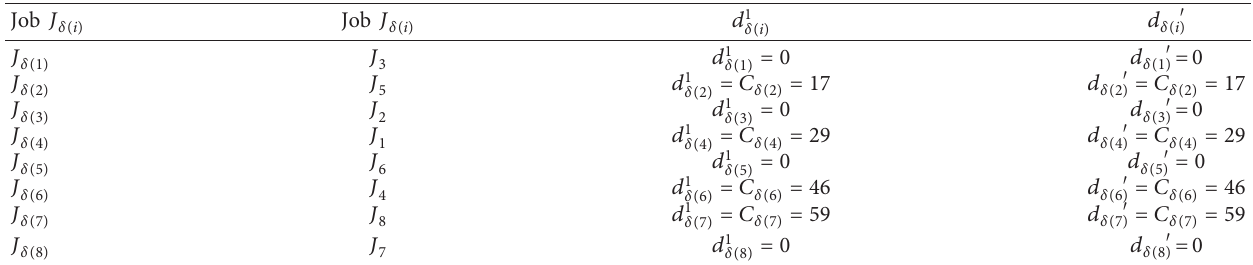
Table 3: Results of the optimal due-window